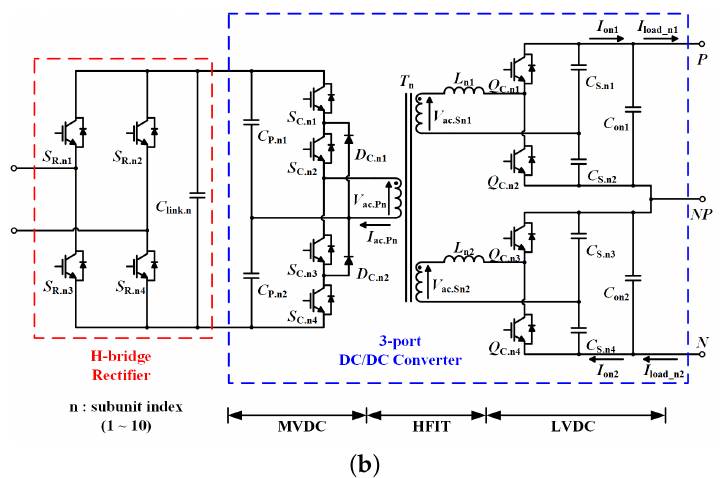
Figure 1. Structure of the SST prototype system: ( a ) simplified structure of the overall SST prototype system; ( b ) detailed structure of one